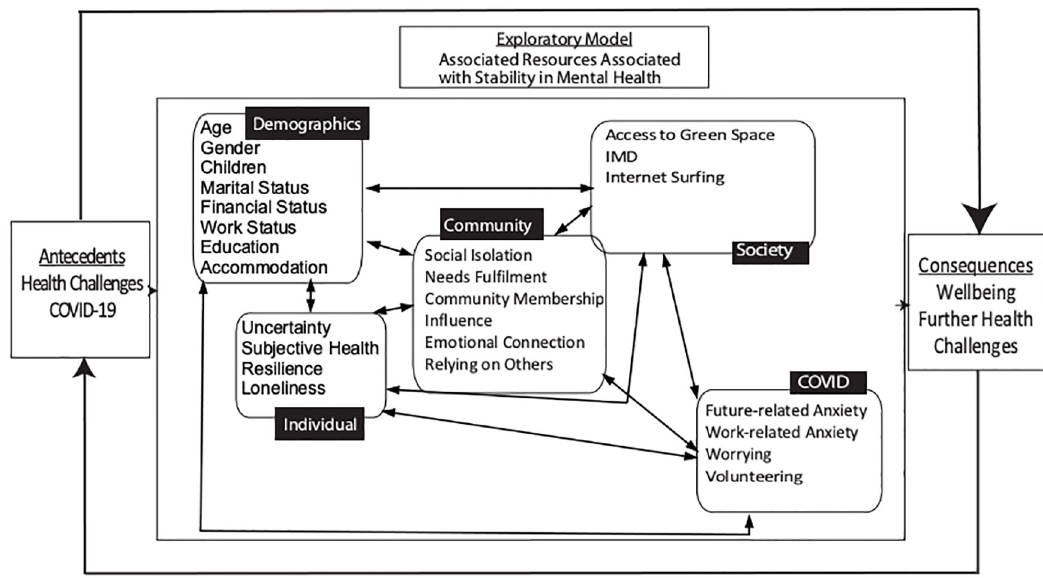
Fig 2. Exploratory model of the associations between the resources in the ecologcial model and mental health.